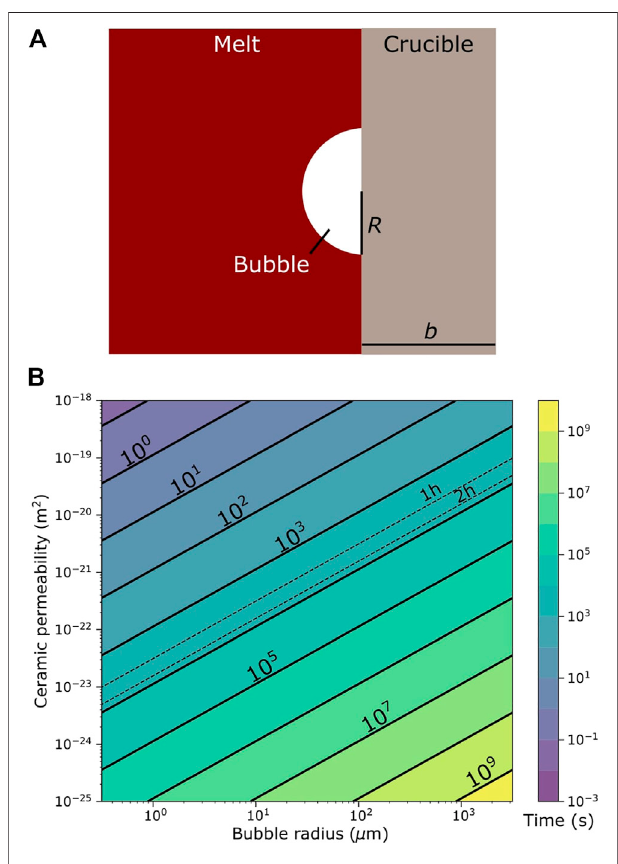
FIGURE 8 | Time t Darcy necessary to deplete a half-bubble of gas via permeable fl ow through the ceramic crucible. (A) Geometry of the problem and (B) colour map of t Darcy as a function of the permeability of the ceramic material k (m 2 ) and bubble radius R ( μ m). Solid lines are isochrones, plottedforeverylog 10 unit.Experimentaldurations(1and2 h)aredisplayedas dashed lines.